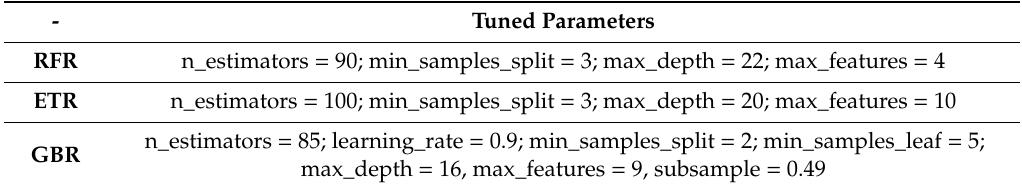
Table 4. Tuned parameters for the employed machine learning (ML) models.